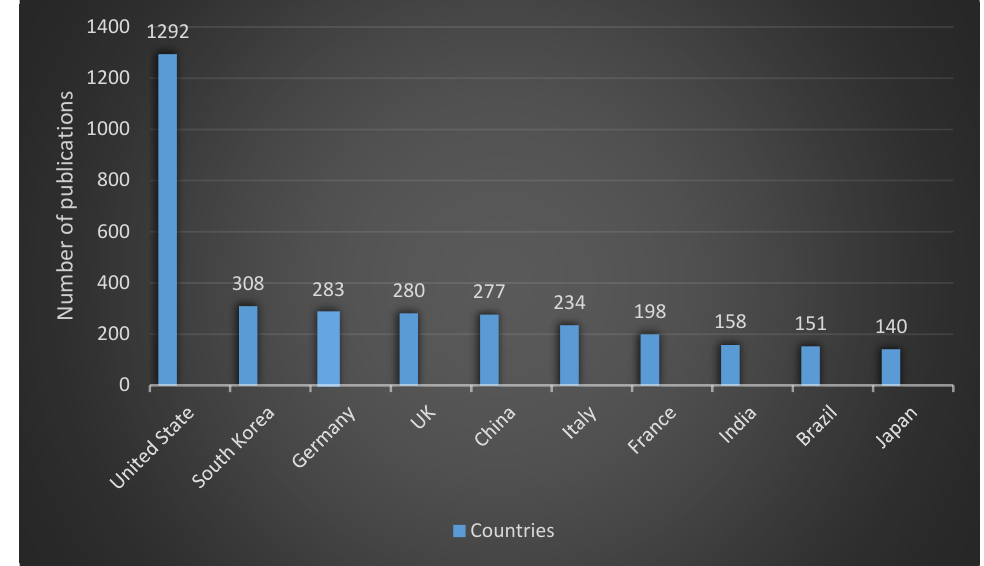
Figure 1. Top 10 countries publishing cosmetic-related adverse effect publications by the total number of documents.